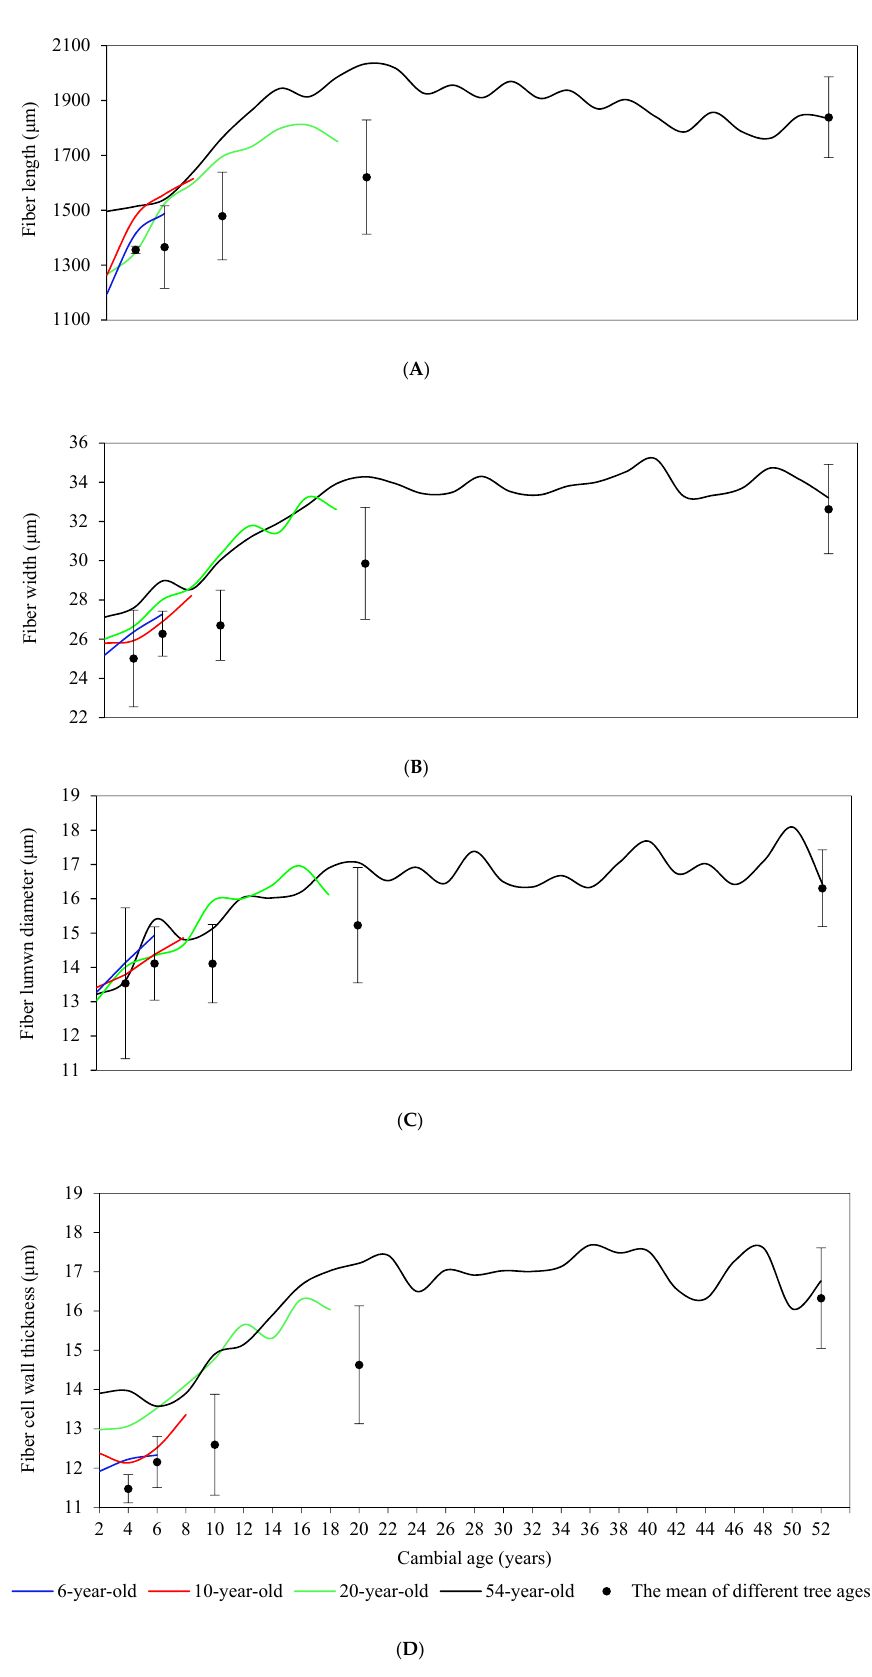
Figure 4. The radial variation in fiber characters versus cambial age and the mean of different tree ages in S. superba , including fiber length ( A ), fiber width ( B ), fiber lumen diameter ( C ) and fiber cell wall thickness ( D ).